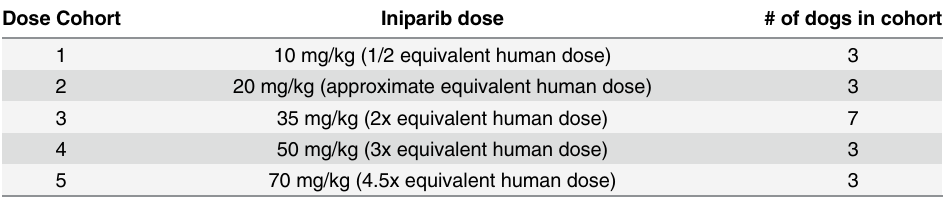
Table 2. Iniparib Dose Escalation cohorts in tumor bearing